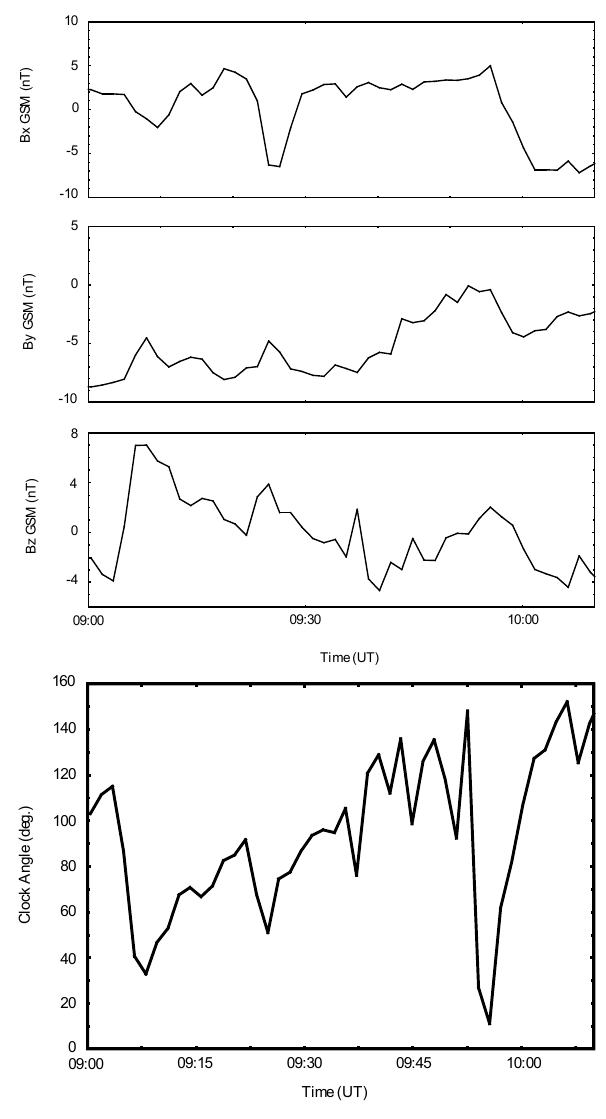
Fig. 1. (a) The three components of the IMF measured by the WIND satellite between 09:00UT and 10:10UT on 24 January 1999, and (b) the corresponding clock